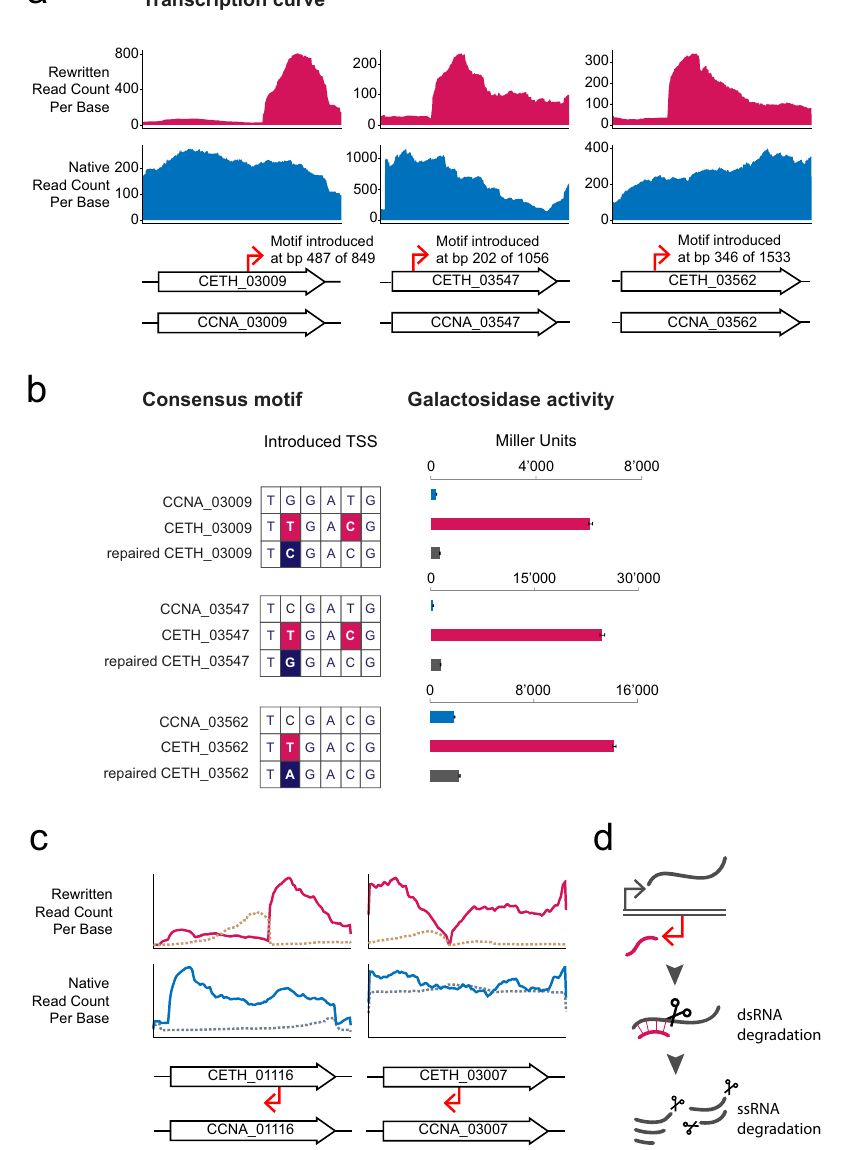
Fig. 4 The emergence of novel transcription start sites. a Emerging TSSs in intergenic regions or within upstream genes point to a − 35 box consensus motif for the principal sigma factor in Caulobacter crescentus , RpoD. The promoter symbol and bp position mark the position of the consensus motif at − 35 bp of the emergent TSS. The x - and y -axis have been adjusted to scale each set and to highlight the difference between rewritten and native transcription curves, respectively. CCNA_03009 is 849 bp, CCNA_03547 is 1056 bp, and atpA (CCNA_03562) is 1533 bp. Magenta trace: rewritten read count, blue trace: native read count. b Heavy fi ring can be signi fi cantly diminished by synonymous replacement of a single nucleotide within the consensus motif. Data are presented as the mean of n = 3 measurements ± the SD. Source data corresponding to individual data points is provided as a Source Data fi le. c Antisense interference in CETH_01116 ( divJ ) and CETH_03007. Dashed line: antisense rewritten (top) or native (bottom) read count. d The mechanism by which an emerging antisense TSS can lead to the depicted transcription curves of CETH_03007 by means of the creation of double- stranded